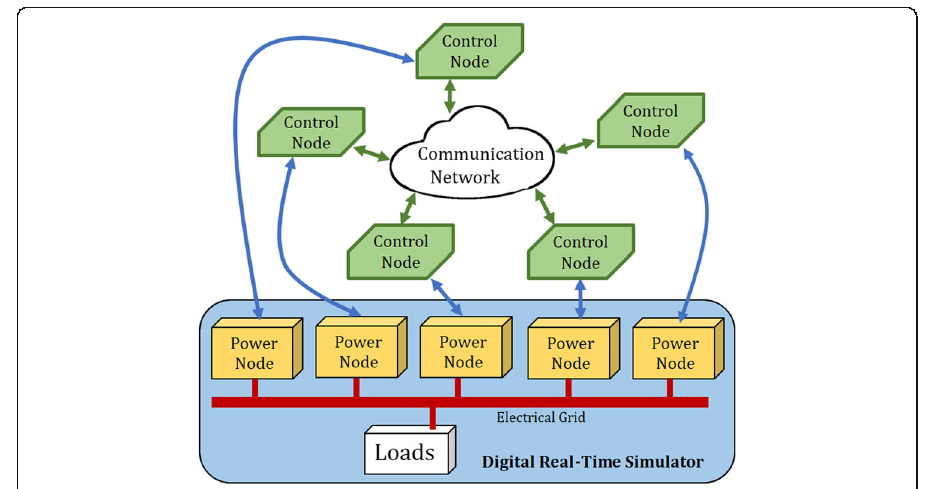
Fig. 3 Structure of the communication and power flow in the example micro grid